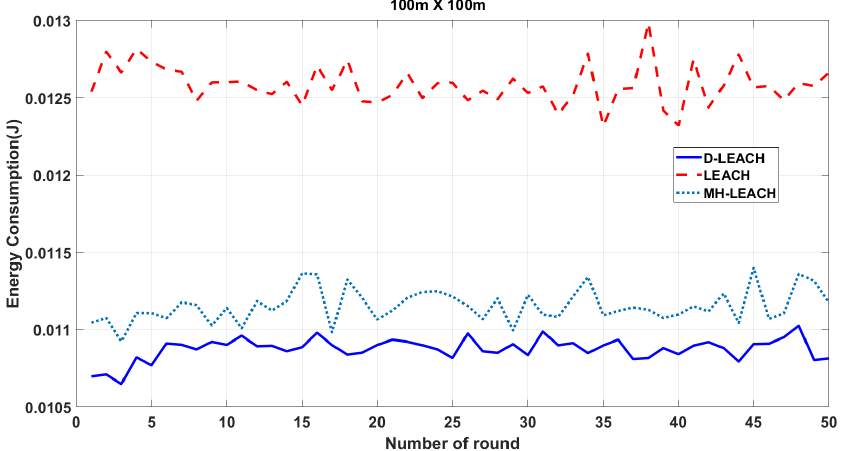
Figure 18. Energy consumption (100 × 100 m 2 ).